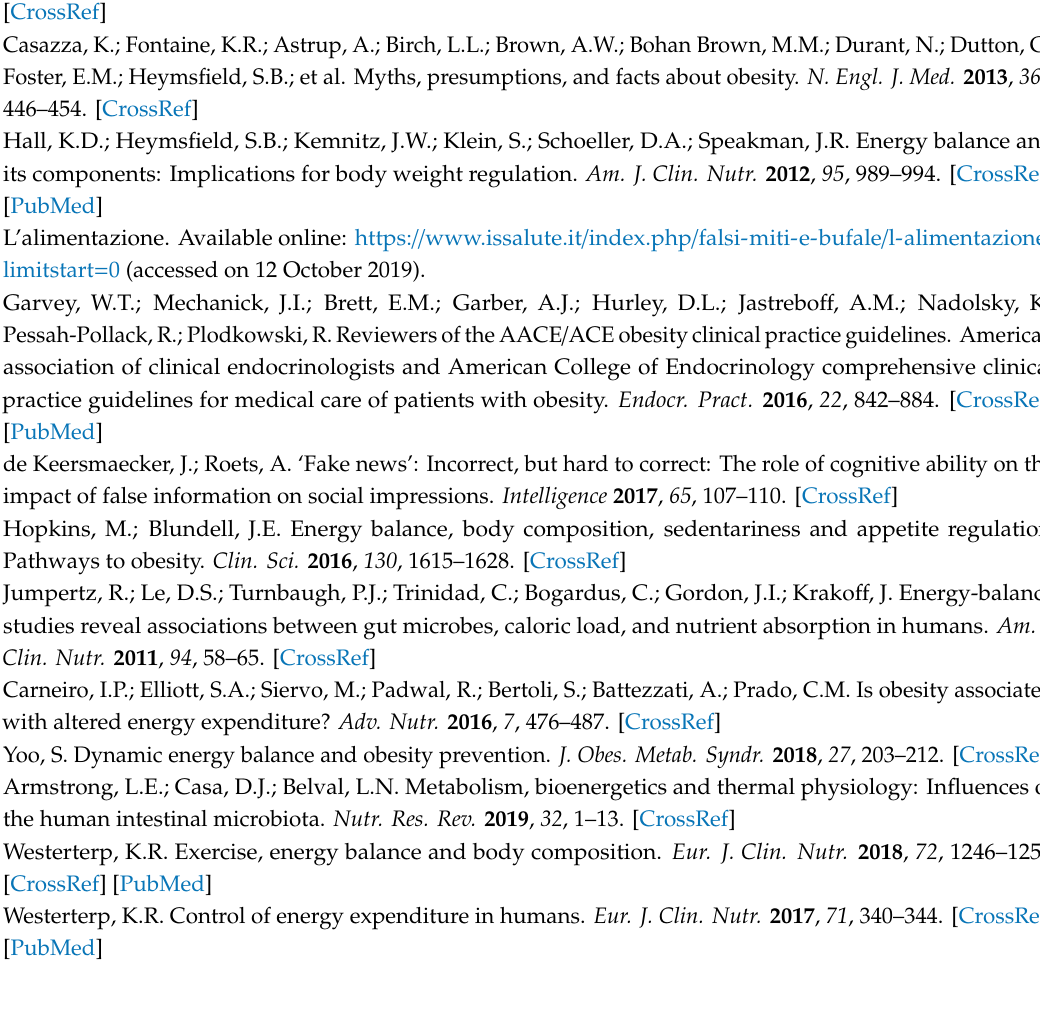
Table S1: E ff ects on energy expenditure and hypothesized mechanisms to induce weight